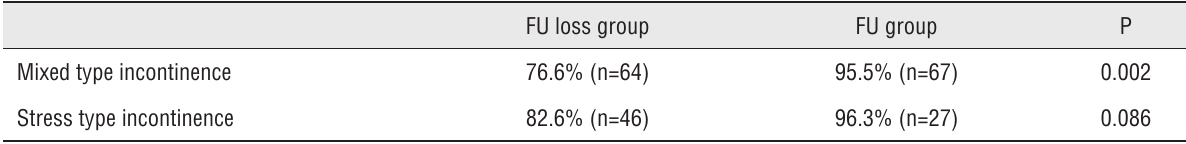
Table 4 - Treatment success rate for the two groups stratified by accompaning symptoms.